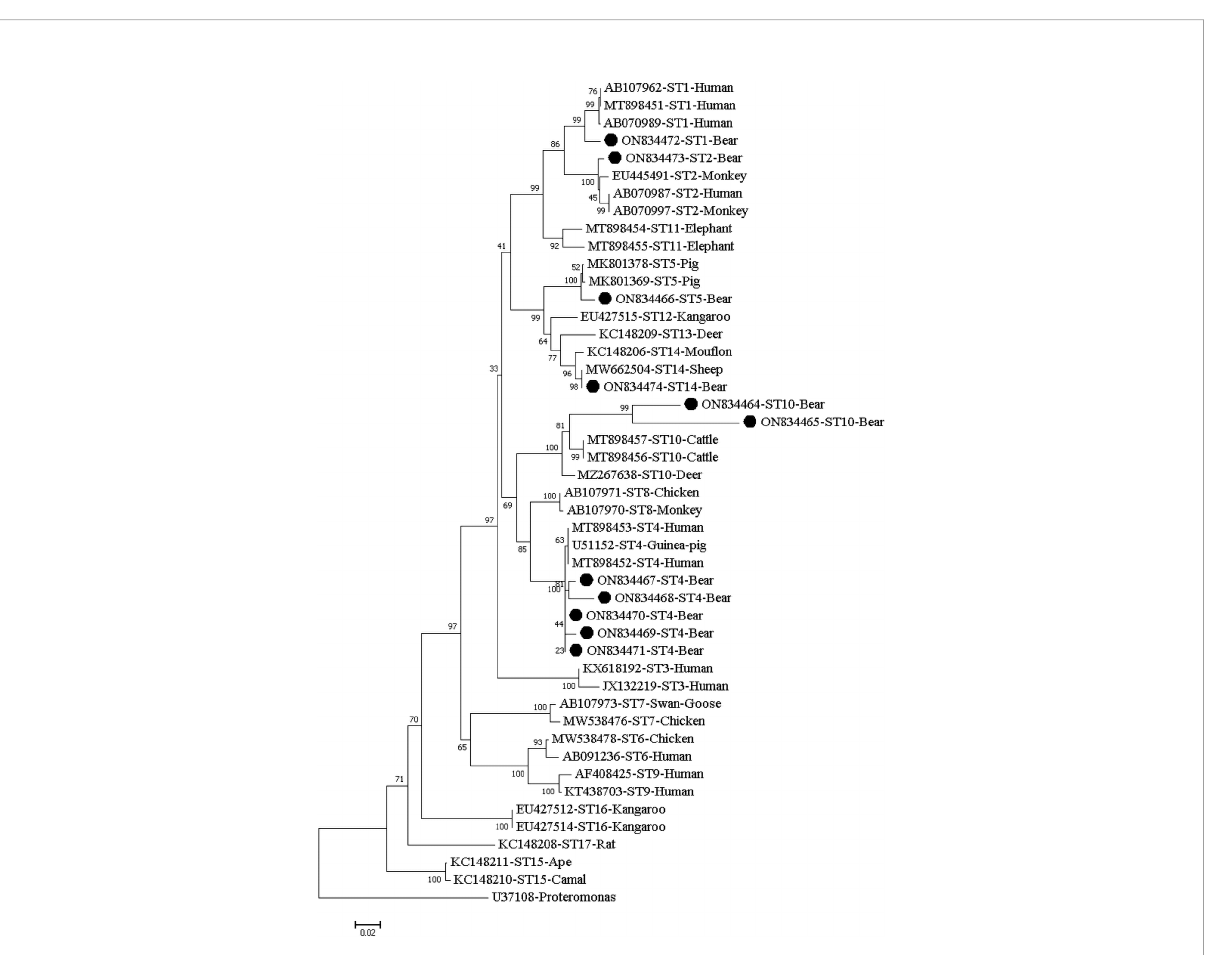
FIGURE 1 Phylogenetic relationship of the STs of Blastocystis isolates from fecal samples of captive Asiatic black bears. The relationship of the Blastocystis subtypes identi fi ed here to some known subtypes stored in the Genbank was inferred by a neighbor-joining (NJ) method based on evolutionary distances calculated using the Kimura two-parameter model. Bootstrap values were obtained using 1000 replicates. Each sequence is identi fi ed by its GenBank accession number, host origin, and ST subtype. The sequence of the ST subtype identi fi ed in the present study is indicated by a black